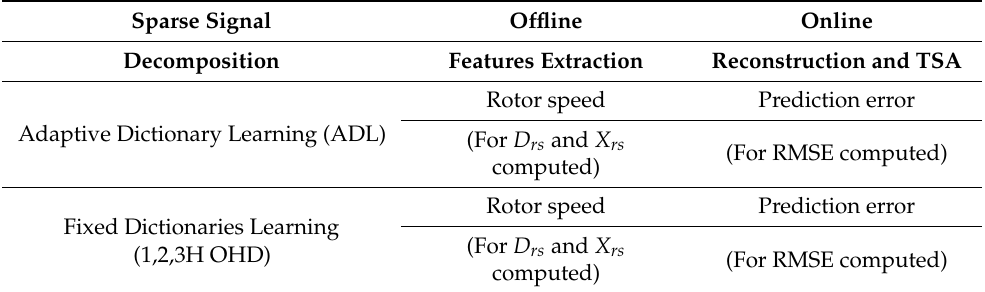
Table 2. Configuration of stable and unstable sparse signal decomposition for TSA.